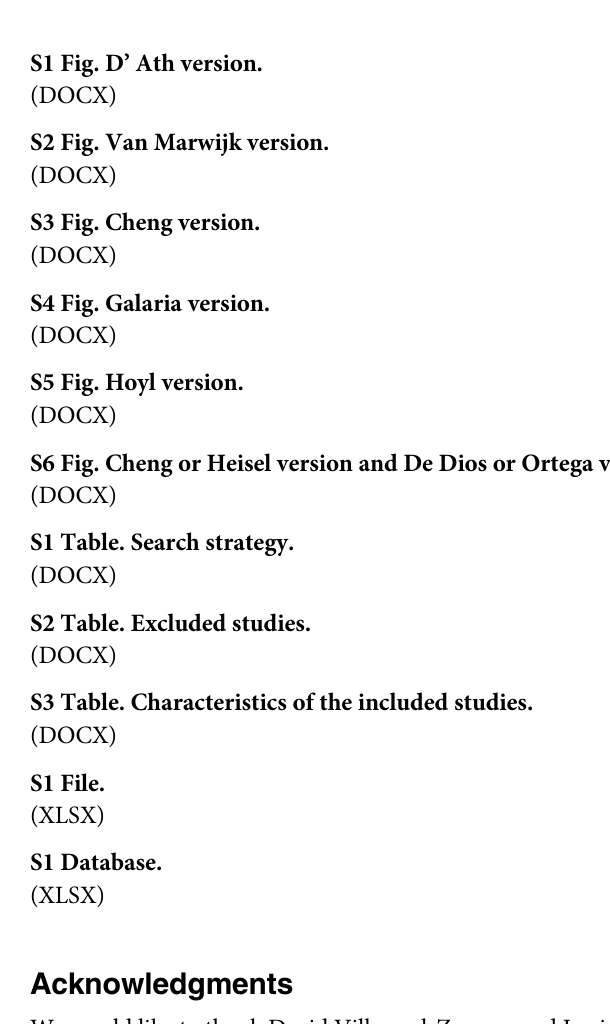
S5 Fig. Hoyl version. S6 Fig. Cheng or Heisel version and De Dios or Ortega version. S1 Table. Search strategy. S2 Table. Excluded studies. S3 Table. Characteristics of the included